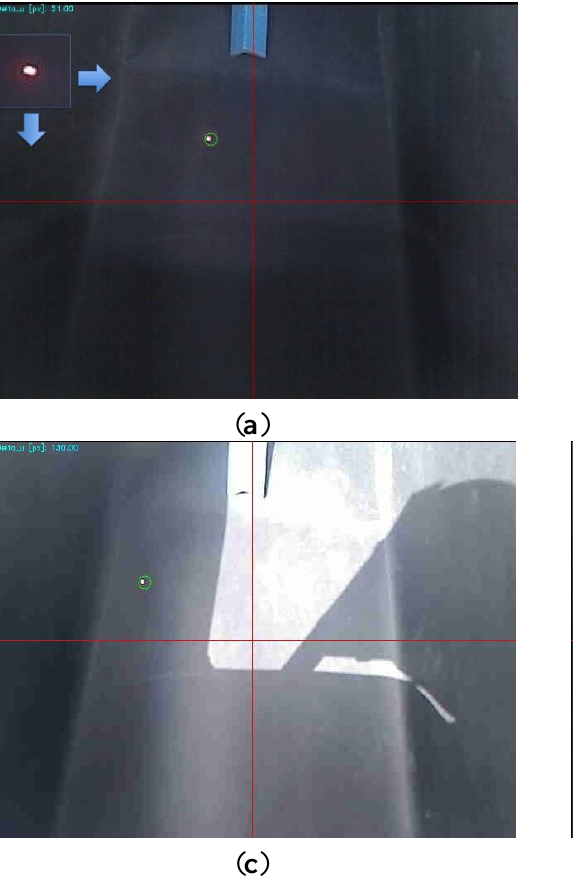
Figure 8. Results of some physical experiments testing the performance of the template matching approach. ( a ) Closed environment (similar light conditions to a warehouse). Note the template used at the top left part of the figure. ( b ) Greenhouse (diffuse light conditions). ( c ) Outdoor environment with direct sunlight conditions. Note the success of the matching detecting a very small laser point. ( d ) Outdoor environment with direct sun light (false